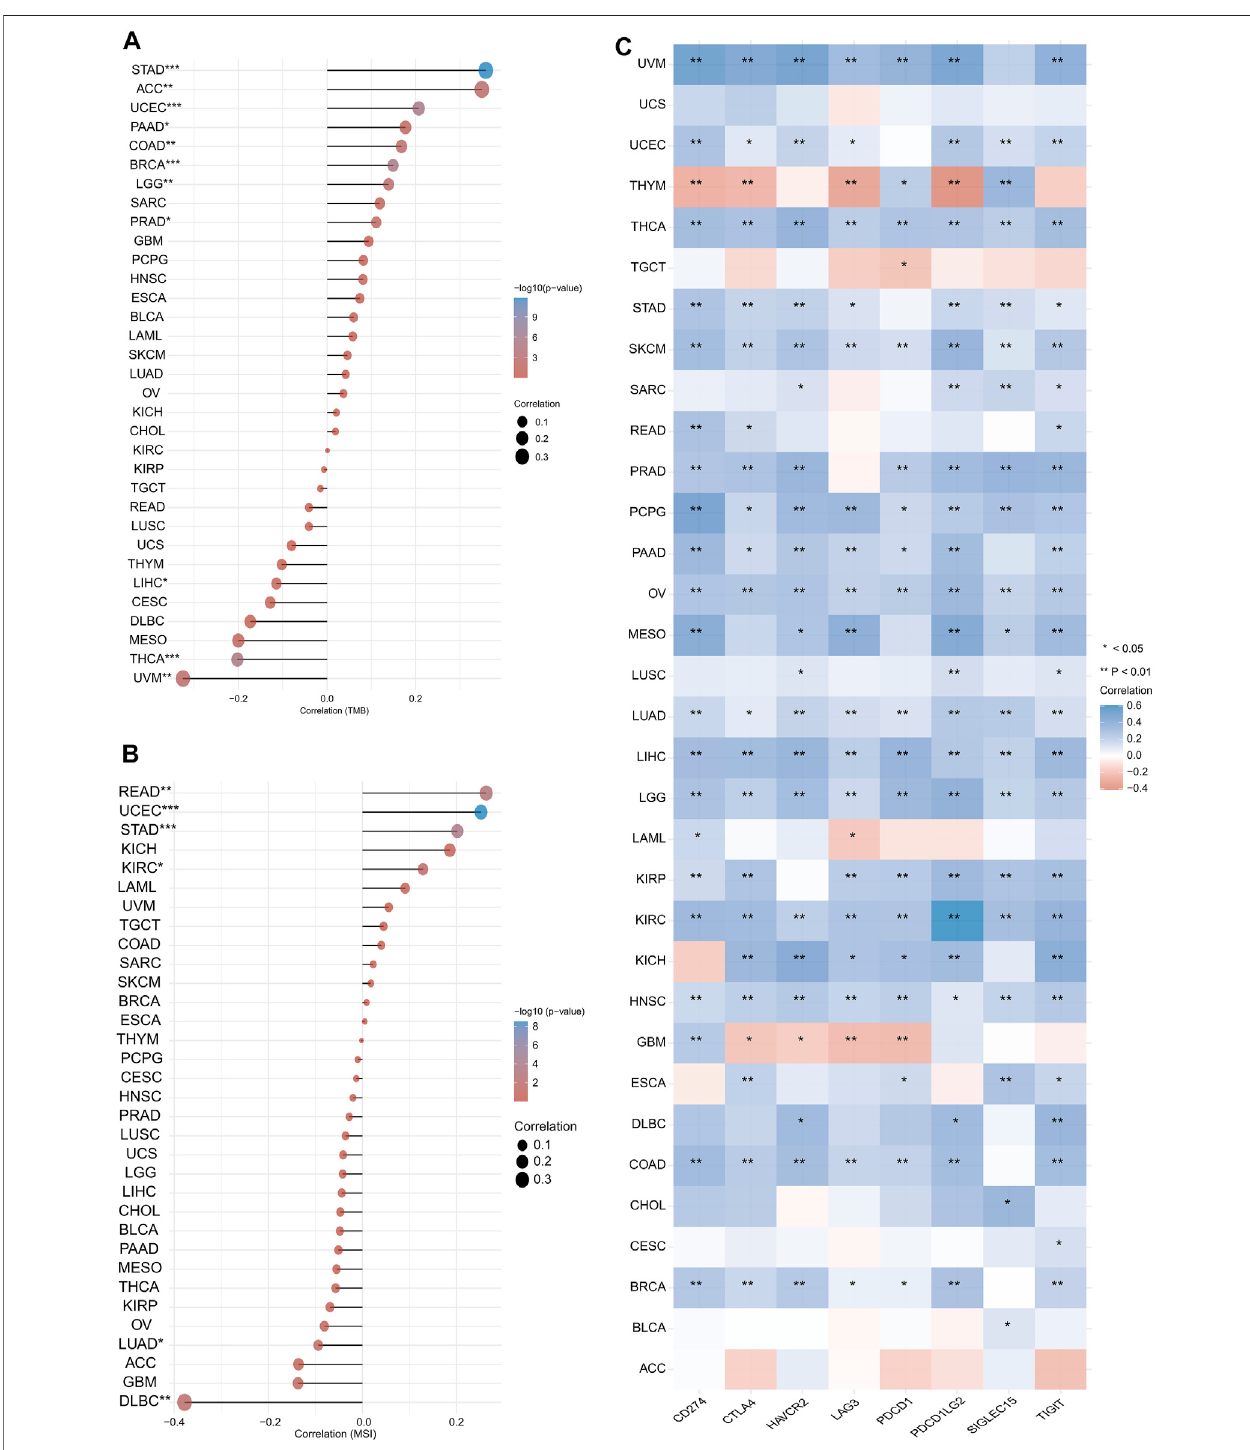
FIGURE7| Expressionof CASP3 inrelationtoTMB,MSIandimmunologiccheckpoint. (A) therelationshipbetweentheexpressionof CASP3 geneandTMB.* p < 0.05, ** p < 0.01, *** p < 0.001. (B) Relationship between expression of CASP3 and MSI. * p < 0.05, ** p < 0.01, *** p < 0.001. (C) Correlationanalysis between expression of CASP3 and immunologic checkpoint-related genes in 33 kinds of tumours. * p < 0.05, ** p < 0.01, *** p < 0.001.